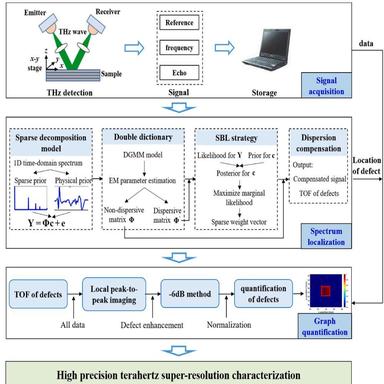
Flowchart of THz super-resolution characterization of GFRP composites.